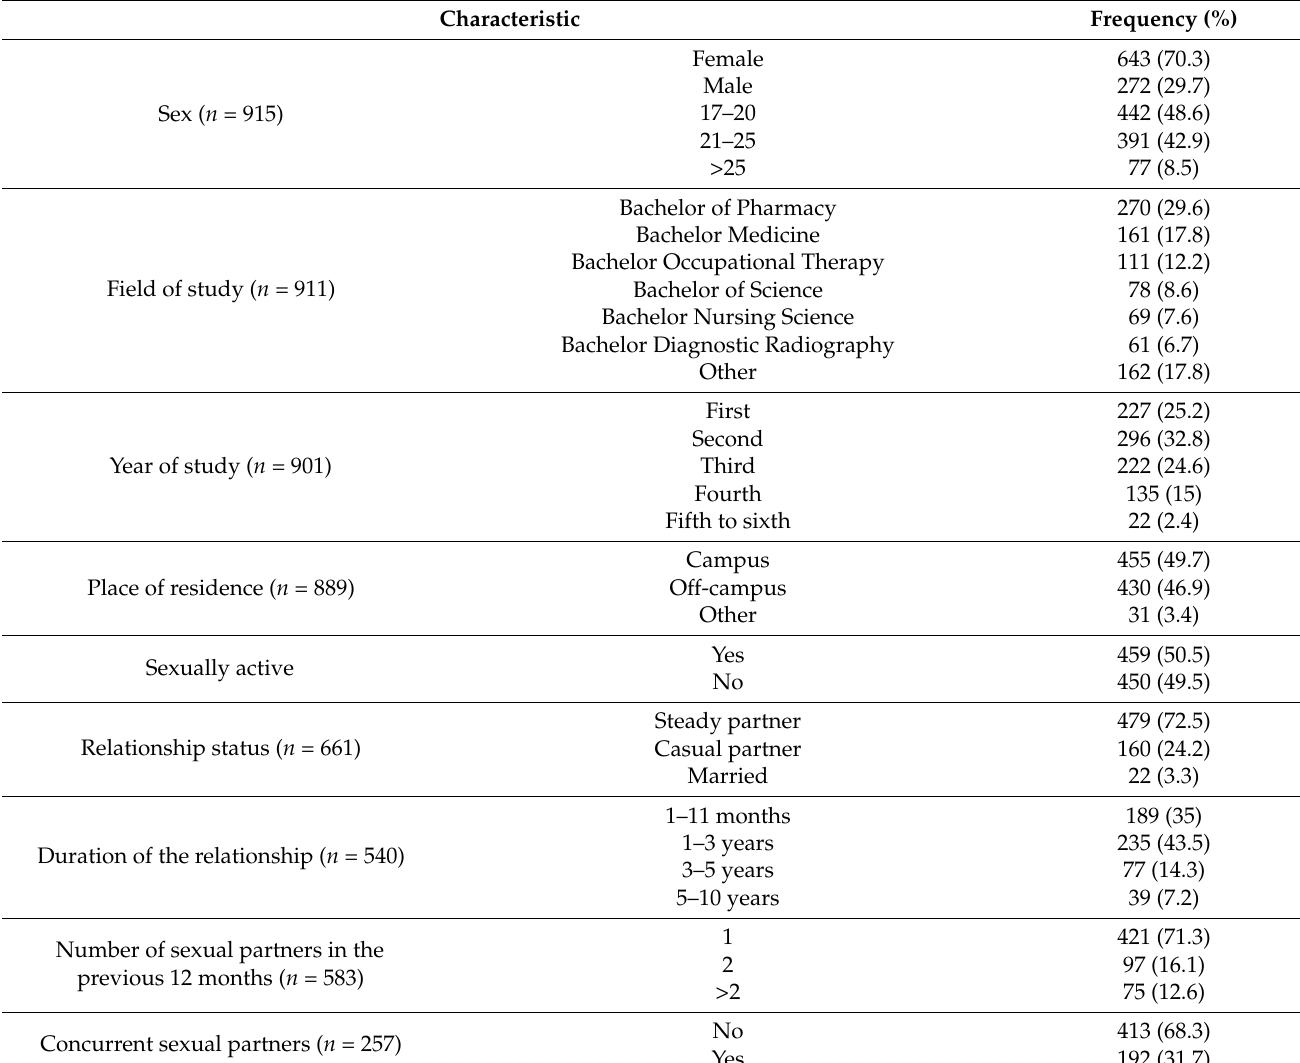
Table 1. Distribution of sociodemographic and behavioural characteristics of university students ( n = 918).